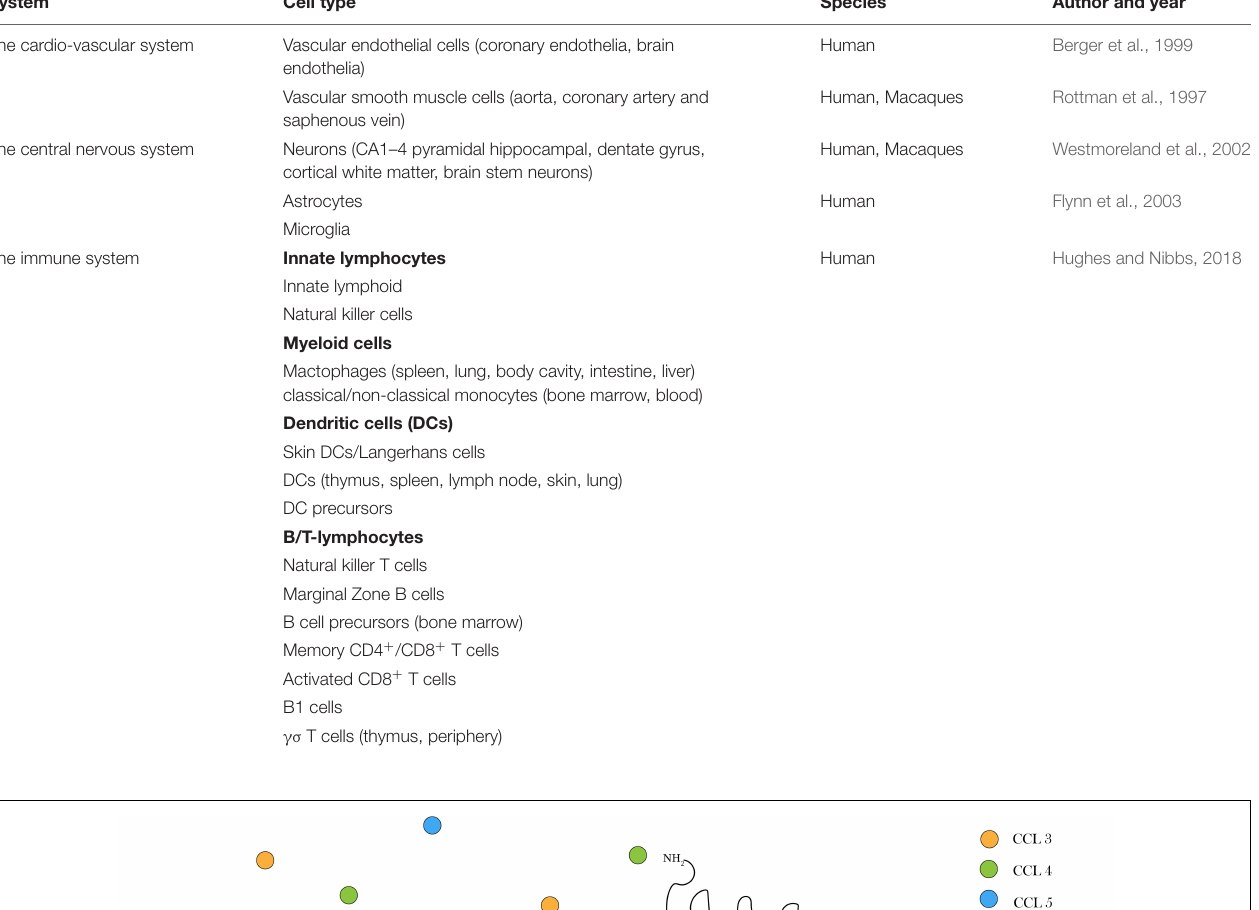
TABLE 1 | Expression of CCR5 genes in cells.